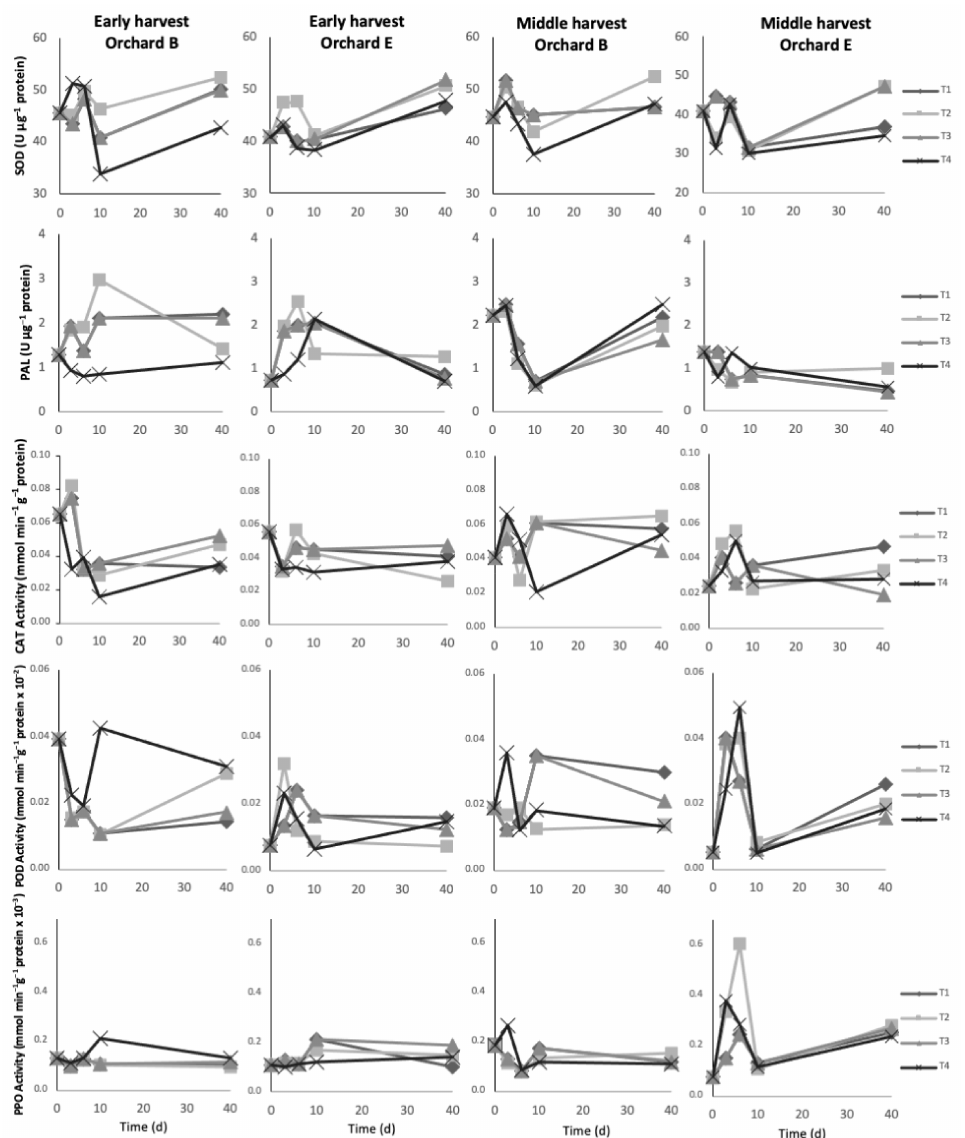
Figure 4. Evolution of enzymatic activity of superoxide dismutase (SOD), phenylalanine ammonia- lyase (PAL), catalase (CAT), peroxidase (POD) and polyphenol oxidase (PPO) of avocado fruit epicarp during different postharvest treatments. The ( first ) column shows fruit from the early harvest of orchards B; the ( second ), from the early harvest of orchards E; the ( third ), from the middle harvest of orchard B; and, the ( last ) column from the middle harvest of orchard E. T1: 40 d in regular air (RA) at 5 ◦ C; T2: 40 d in controlled atmosphere (CA) 4 kPa O 2 and 6 kPa CO 2 at 5 ◦ C; T3: 10 d in RA at 5 ◦ C plus 30 d in CA 4 kPa O 2 and 6 kPa CO 2 at 5 ◦ C; and, T4: 5 µ M MeJA plus 10 d in RA at 5 ◦ C plus 30 d in CA 4 kPa O 2 and 6 kPa CO 2 at 5 ◦